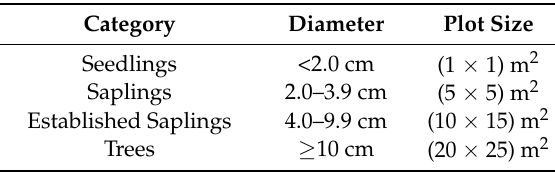
Table 2. Categories of trees and plot size